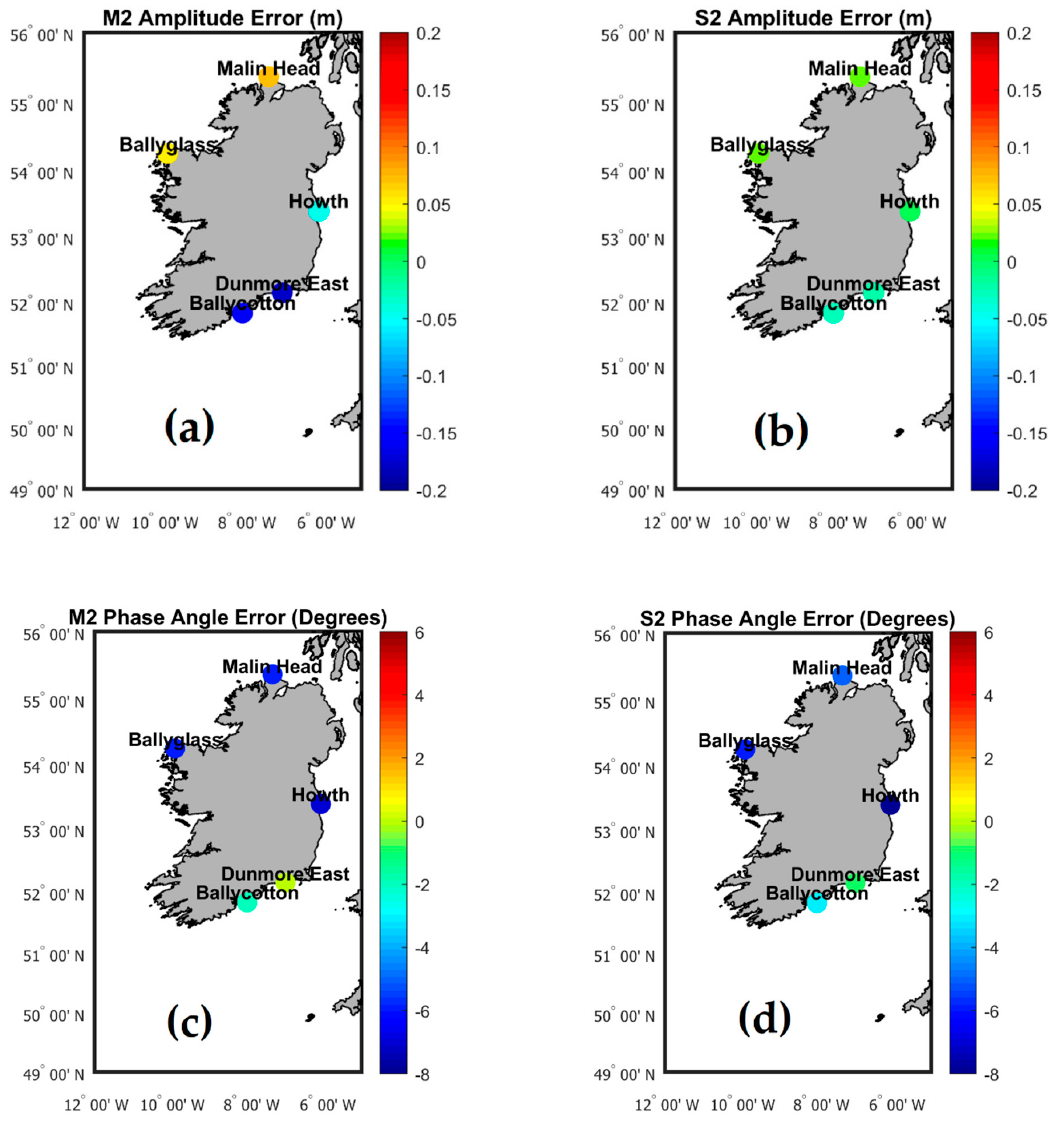
Figure 5. Error maps for NEA_ROMS minus observed amplitudes and phases for M 2 and S 2 tidal constituents at five Irish tide gauge locations, Malin Head, Ballyglass, Ballycotton, Dunmore East, and Howth. ( a ) M2 Amplitude Error (m) ( b ) S2 Amplitude Error (m) ( c ) M2 phase Angle Error (Degrees) ( d ) S2 Angle Error (Degrees).